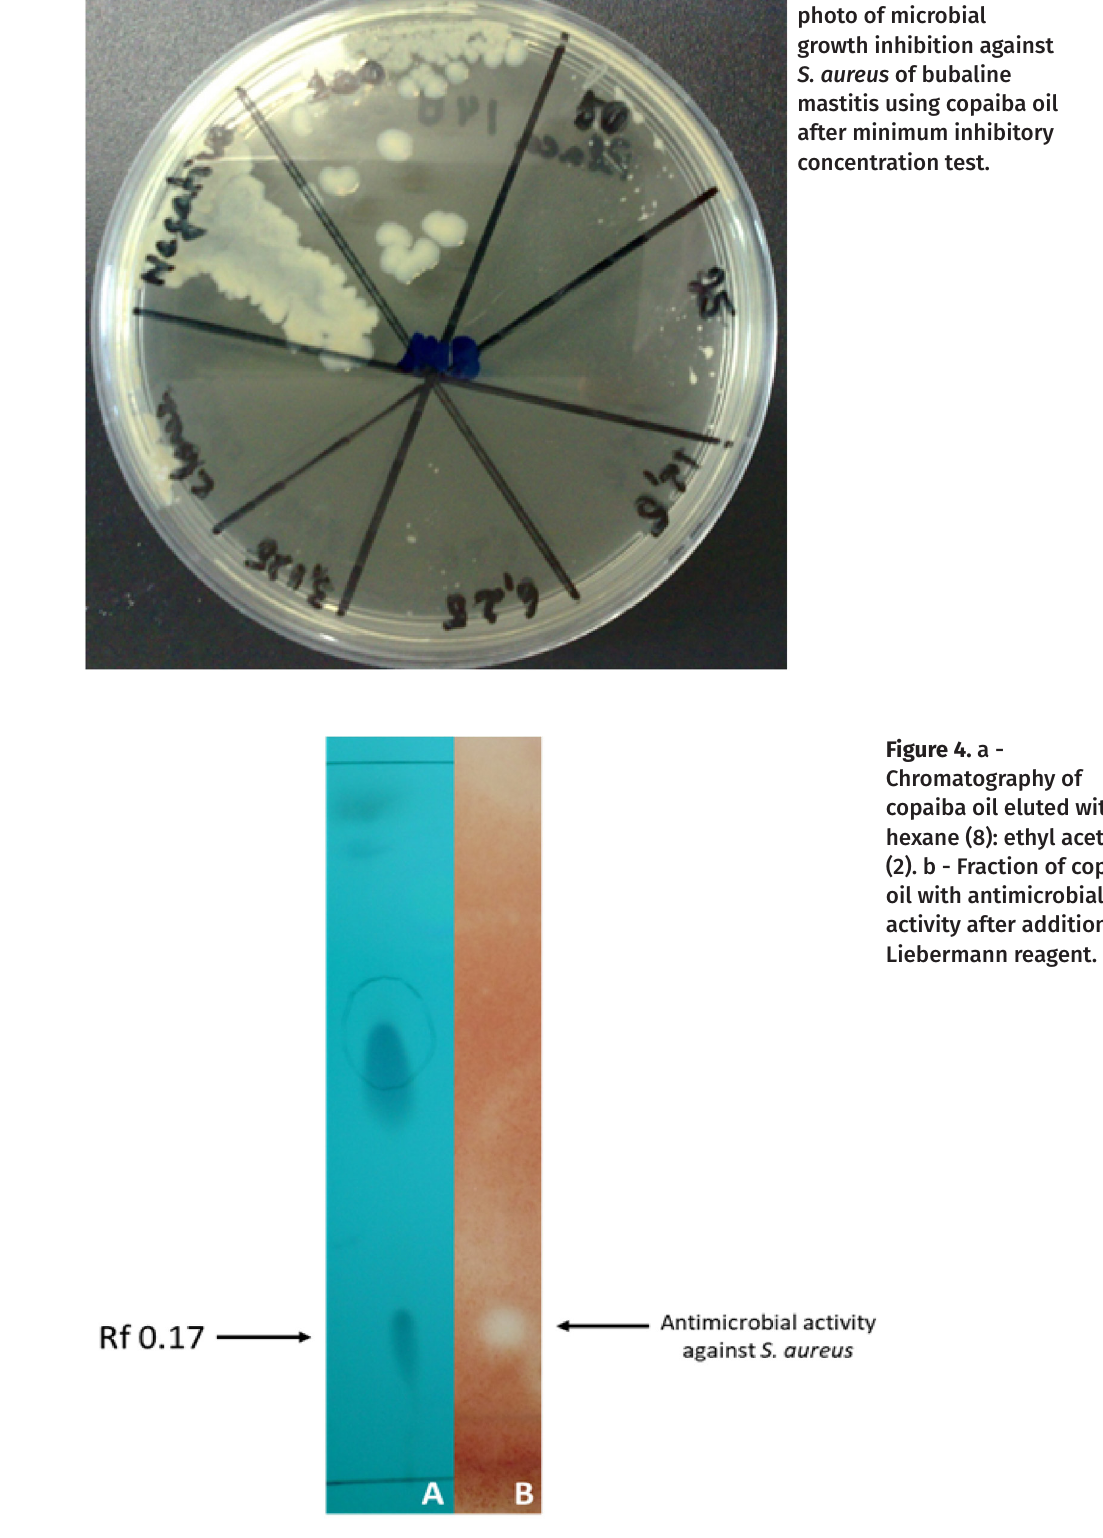
Figure 3. Illustrative photo of microbial growth inhibition against S. aureus of bubaline mastitis using copaiba oil after minimum inhibitory concentration test.